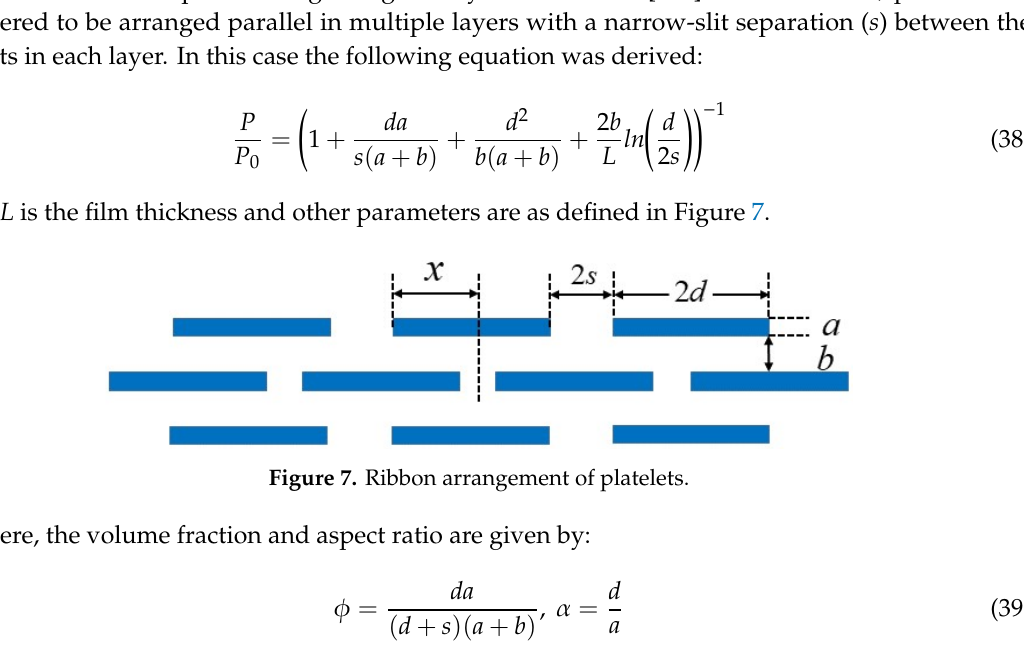
Figure 6. Prediction plot of Nielsen’s model at different aspect ratios.